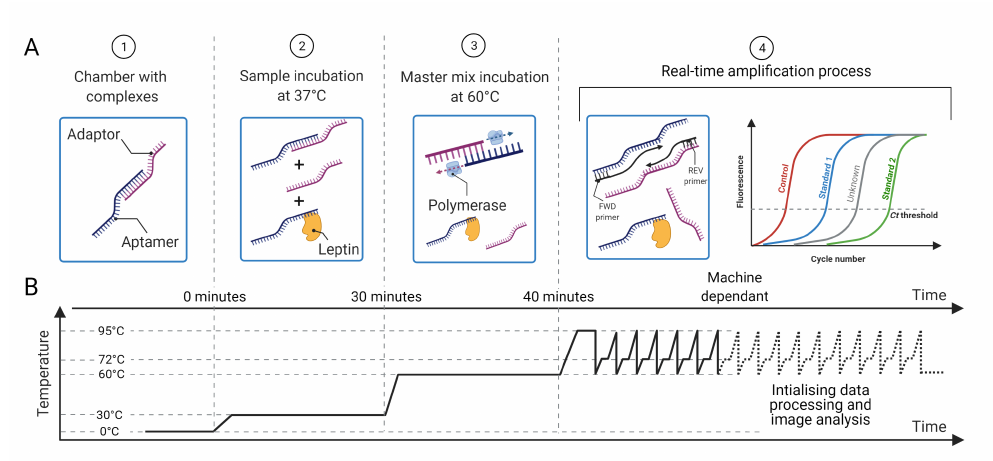
Figure 3. ( A ) Proposed methodology for protein sensing: (1) the chambers are preloaded with aptamer–adaptor complexes; (2) the sample containing the target protein (leptin) is loaded and the protein displaces the complexes proportionally to its concentration; (3) the master mix with the enzyme for complex elongation and qPCR is added; (4) the primers are loaded and the qPCR that amplifies the leftover elongated complexes starts. ( B ) Temperature profile for sample preparation and qPCR, which is preset in the machine. The time taken to quantify the sample is machine dependant as it depends on the amount of aptamer–adaptor complexes formed and retained during the sample preparation steps 1–4. Reprinted/adapted with permission from Ref. [17]. 2021, IEEE.